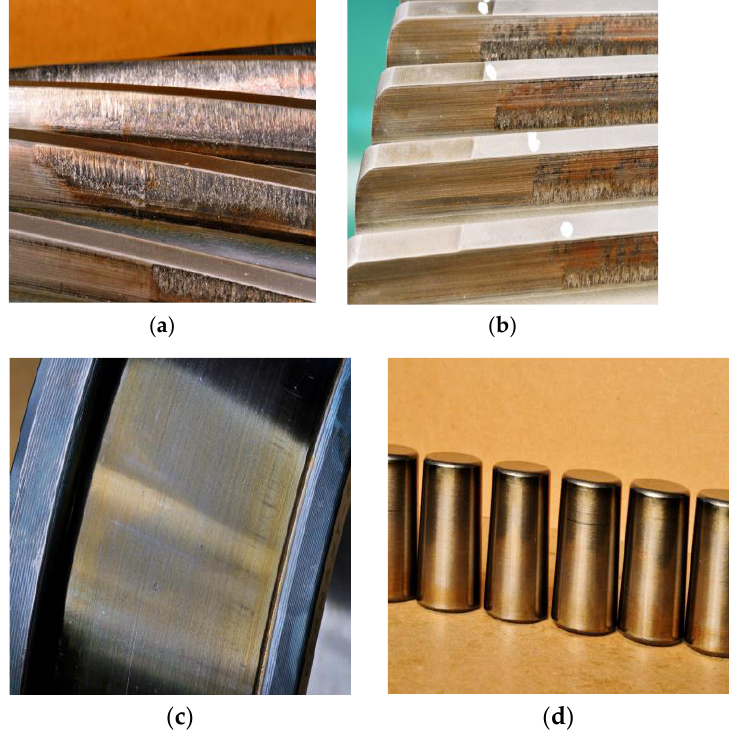
Figure 4. Gear and bearing failure pictures. ( a ) High-speed shaft pinion fault; ( b ) Intermediate speed shaft gear fault; ( c ) Bearing inner ring fault; ( d ) Bearing rollers fault.